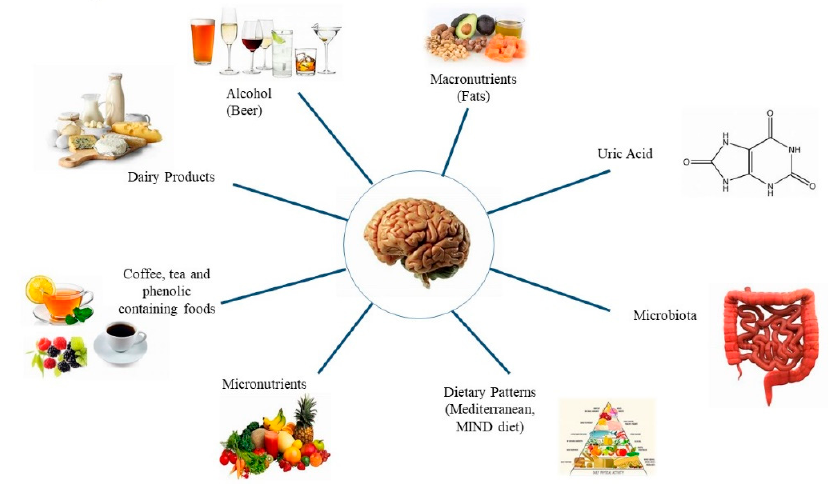
Figure 1 . Factors studied in relation to Parkinson’s disease. Figure 1. Factors studied in relation to Parkinson’s